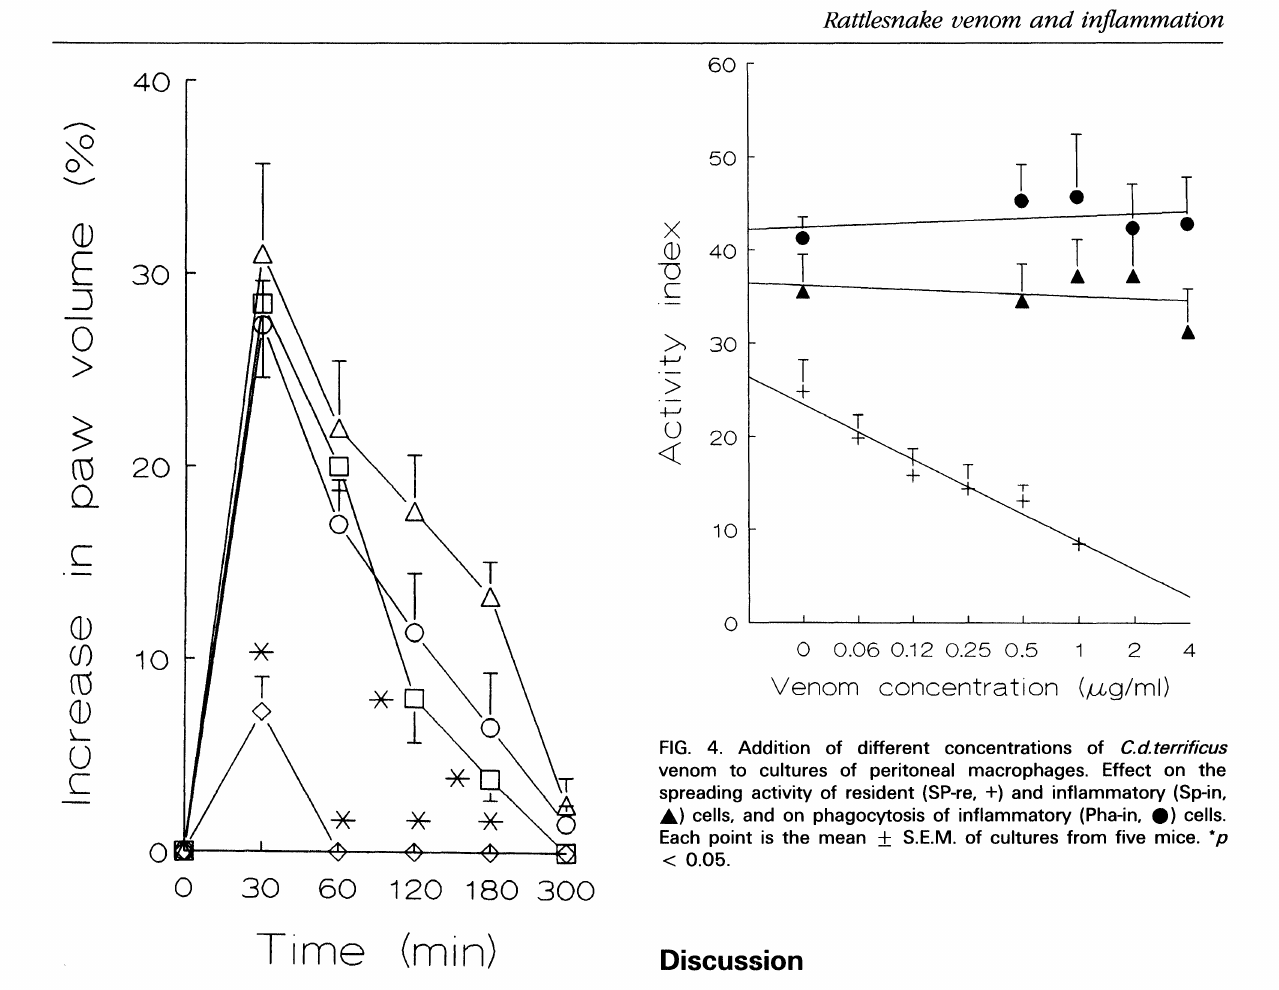
FIG. 3. Paw oedema induced by the injection of different con- centrations of C.d.terrificus venom in untreated groups of mice. One group was treated with promethazine (Promet., 10 mg/kg, i.p., 30 min before) and injected with 1.51g Cdt venom. Each point is the mean -i- S.E.M. of five to eight mice. *p < 0.05. Cdt venom" /k, 1.5 lg; O, 3.0 lg; I--I, 6.0 lg. Promethazine,